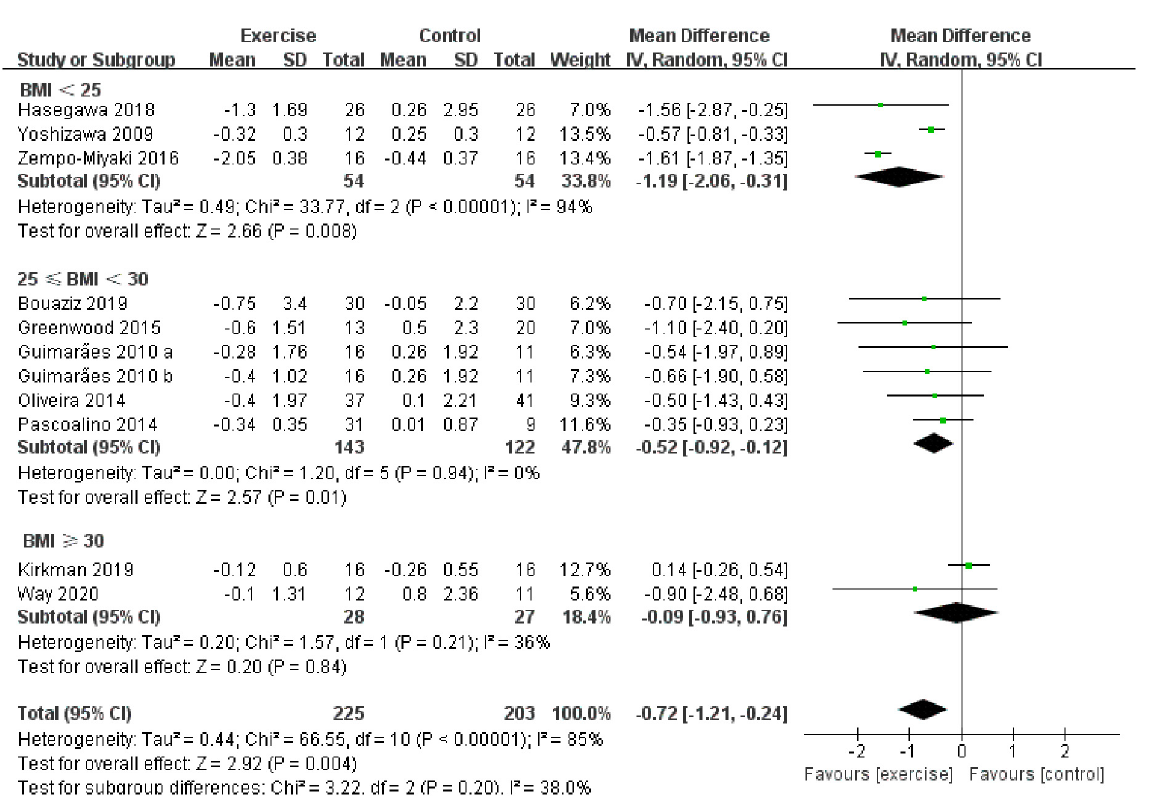
FIGURE8 Meta-analysis results of the effect of aerobic exercise on the PWV of normal weight, overweight, or obese middle-aged and elderly people. The pooled estimates were obtained from random effects analysis. Diamond indicated the size of the effect of each study summarized as WMD. The size of the shaded square is proportional to the percentage weight of each study. Horizontal line represents the 95% CI and the vertical dashed line represents the overall